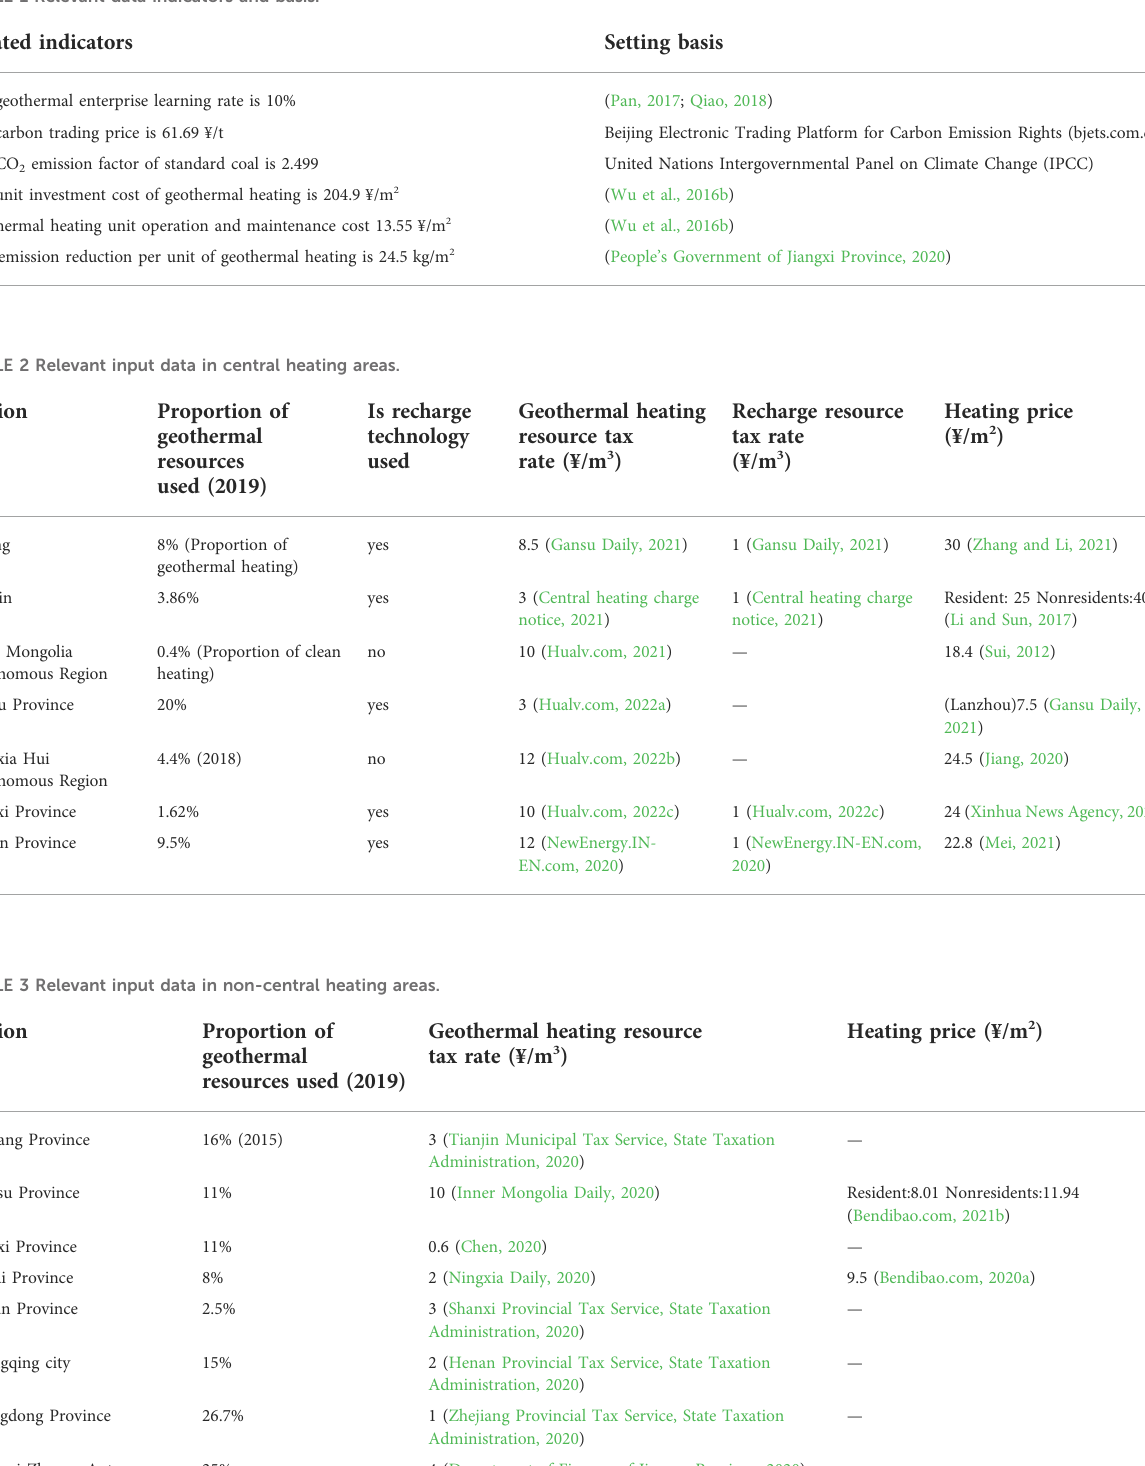
TABLE 1 Relevant data indicators and basis.